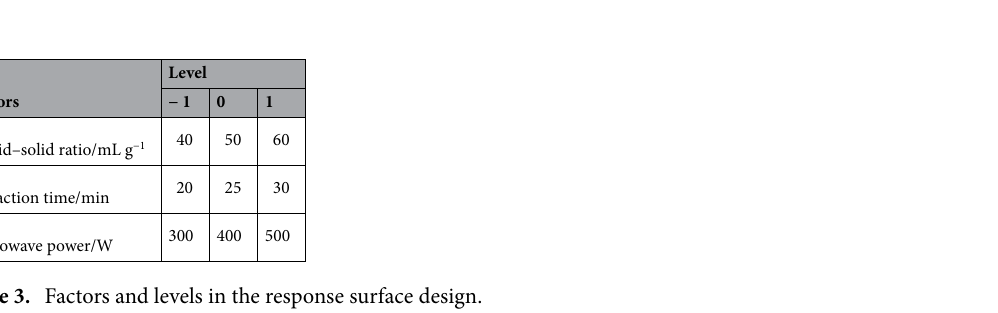
Figure 2. Effect of the liquid–solid ratio, extraction time and microwave power on the yield of sweet cherry flower essential oil.